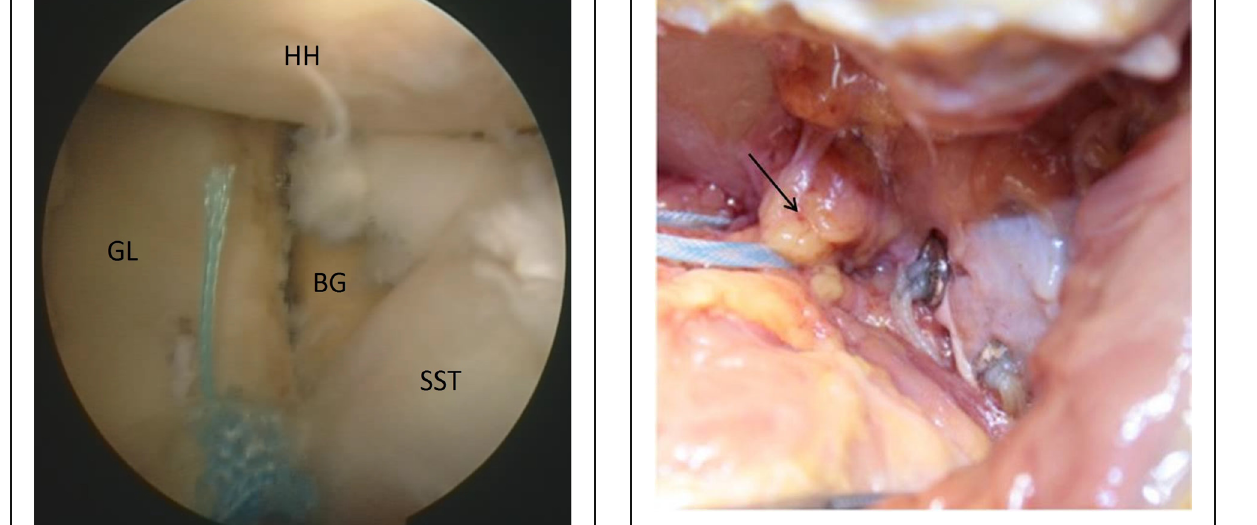
Fig. 10 Posterior side of the scapular neck: absence of interference of the upper graft fixation button with suprascapular nerve (arrow)